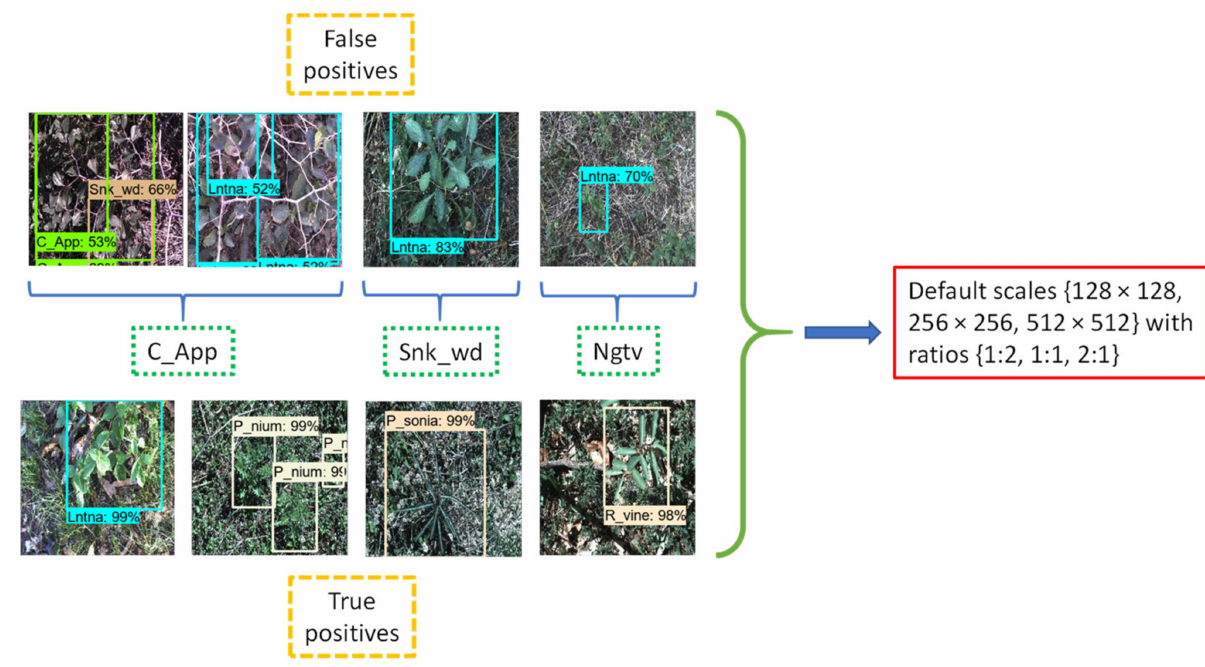
Figure 5. True-positive and false-positive results using the default scale size and aspect